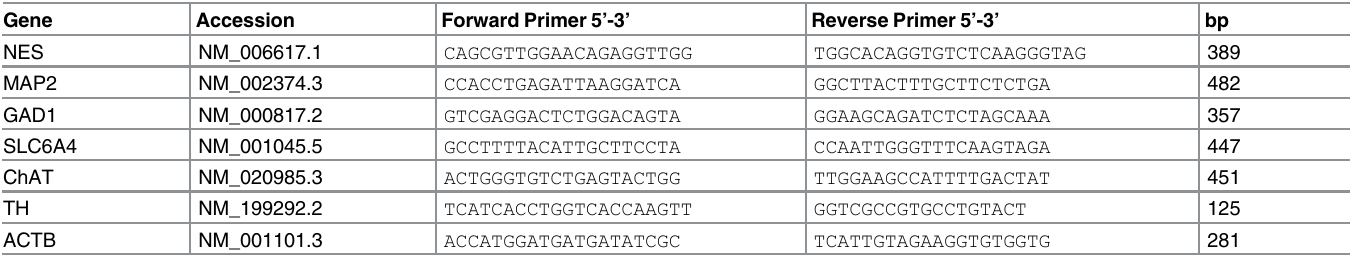
Table 1. RT-PCR primer